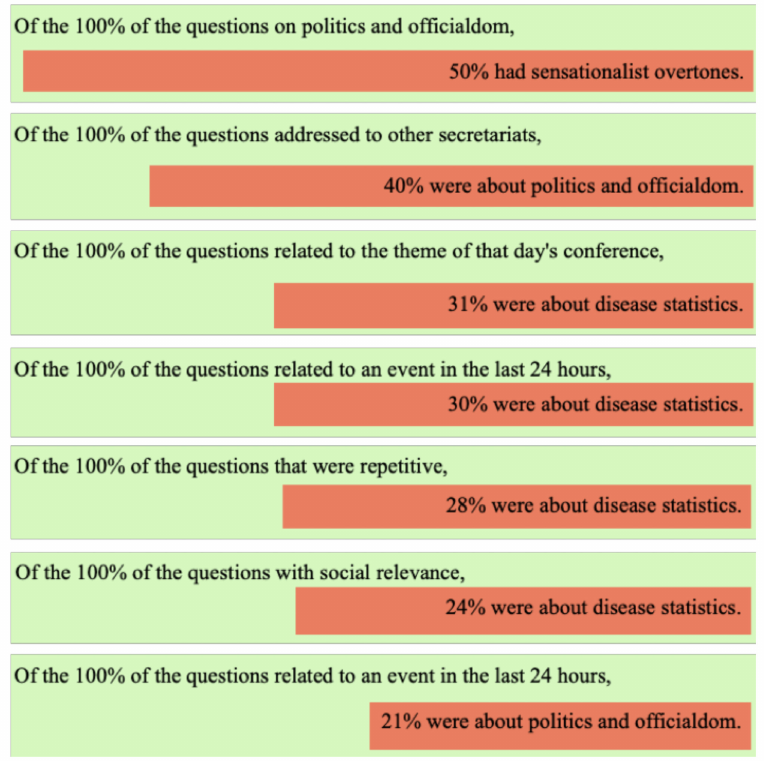
Figure 4. Crossovers between questions characteristics and questions